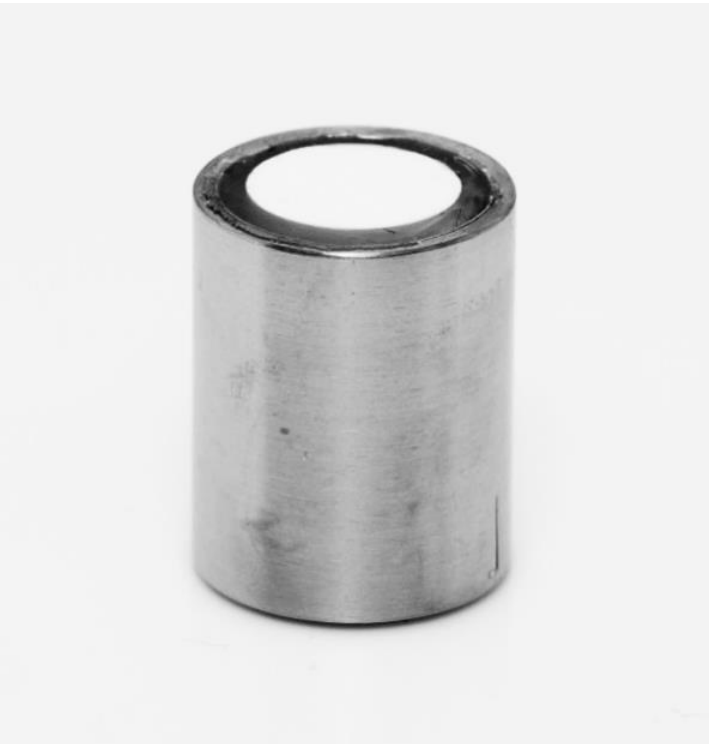
Figure 3. Raw cylinder, glued into a titanium tube, outer diameter 12 mm, inner diameter 10 mm (details see Supplementary Materials).